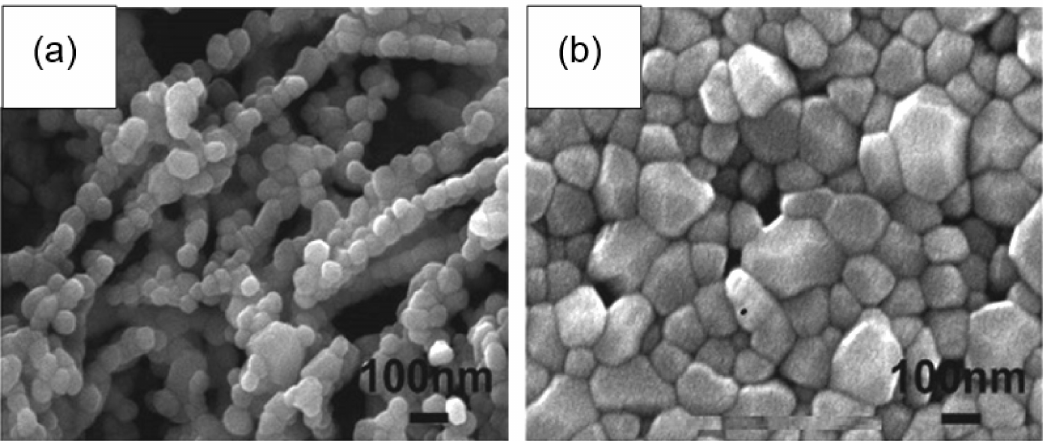
Figure 1. Morphology of WO 3 ( a ) nanofibers and ( b ) films, fabricated using similar parameters. Deposition of W for 180 s, and oxidation at 700 ◦ C in air for 2 h. Reprinted with permission from [27]. Copyright 2012 Royal Society of